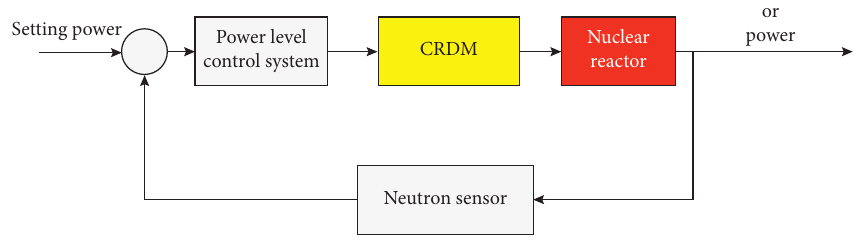
Figure 1: The structure of power level control system in NPP.